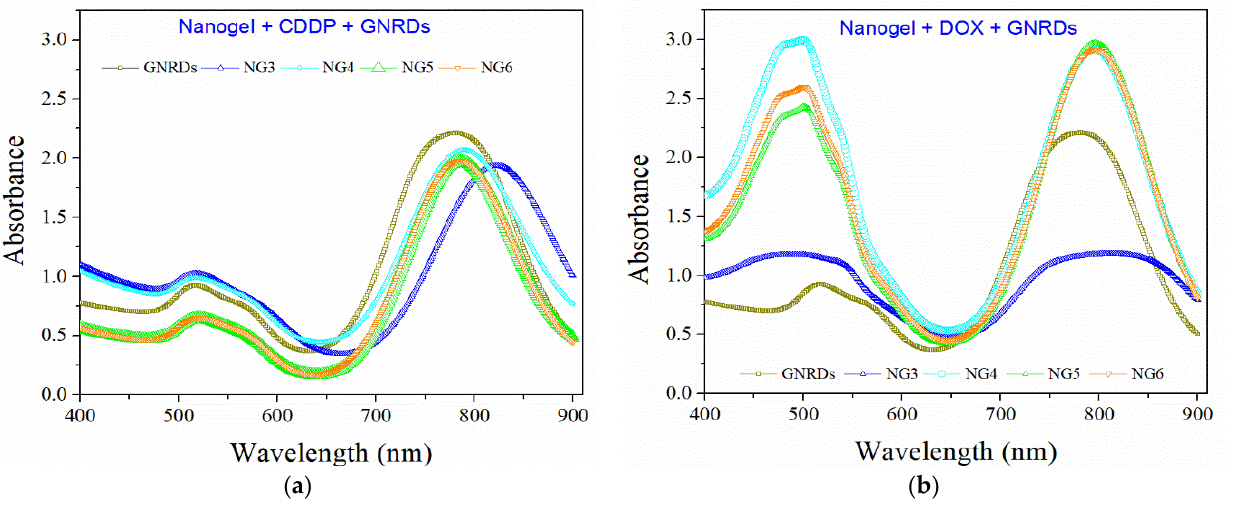
Figure 6. UV-vis spectra of GNRDs: ( a ) GNRDs/CDDP loaded in nanogels; and ( b ) GNRDs/DOX loaded in nanogels.